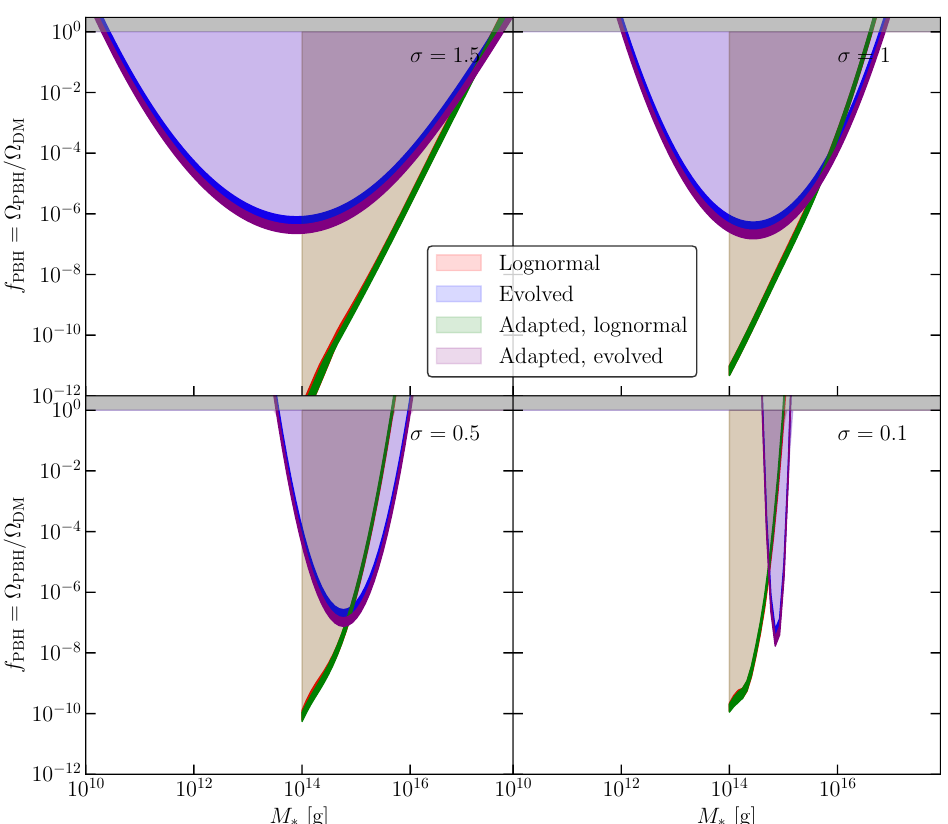
Figure 4: Bounds on f from galactic centre γ -ray observations for extended dis- pbh tributions with central mass M ∗ and four values of σ , comparing the the ‘naive’ log- normal and properly evolved distributions. The thickness of the borders accounts for observational uncertainty. ‘Adapted’ curves are obtained from monochromatic constraints using the method of Ref. [ 10 ]